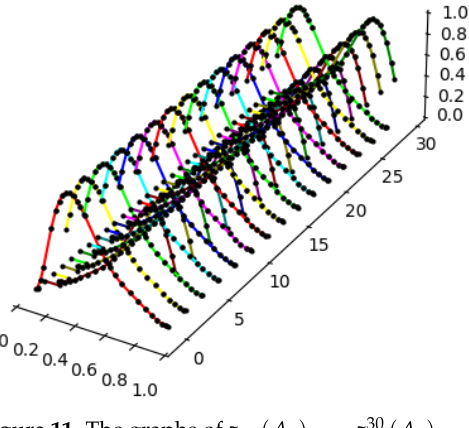
Figure 11. The graphs of z l